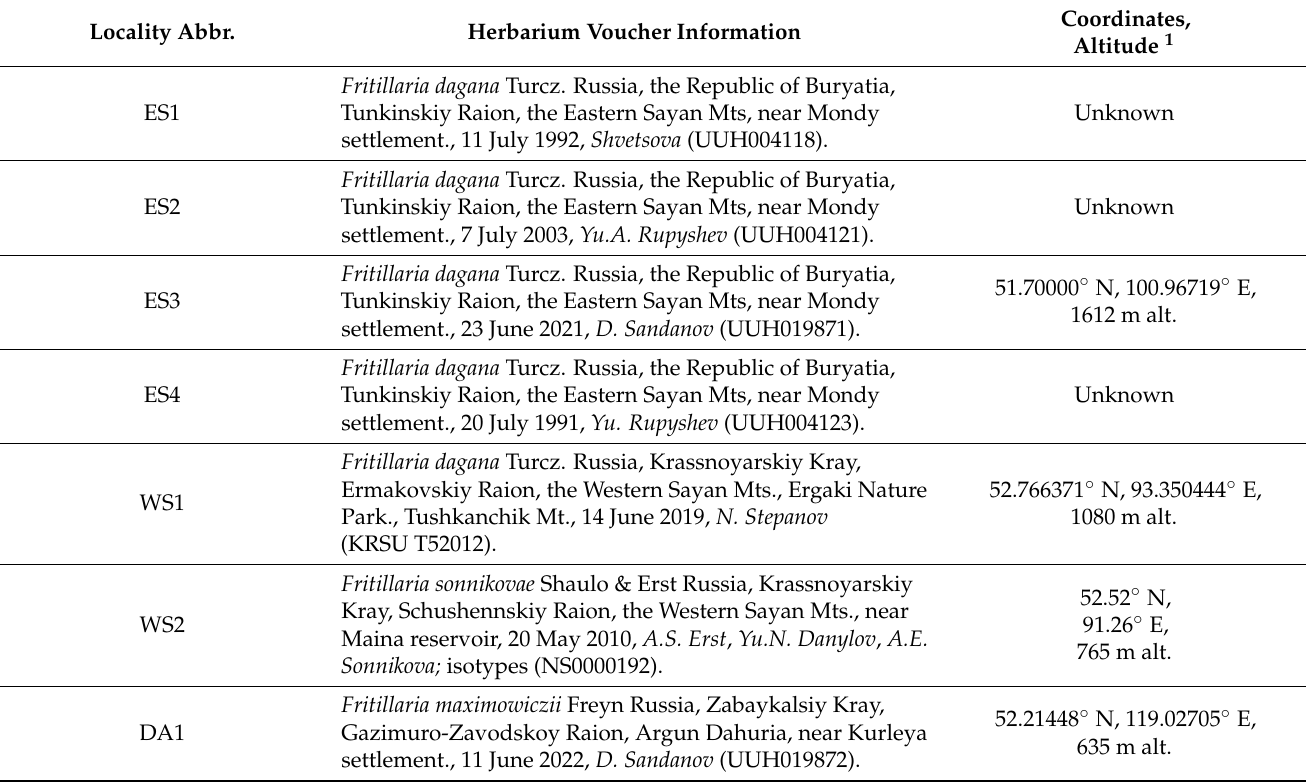
Table 1. The list of Fritillaria sampling for DNA